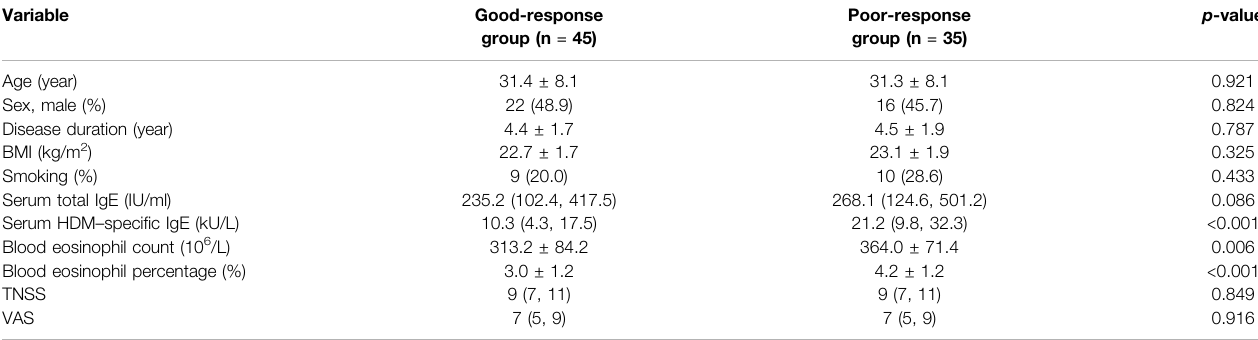
TABLE 4 | Demographic and clinical variables between two groups. Variable